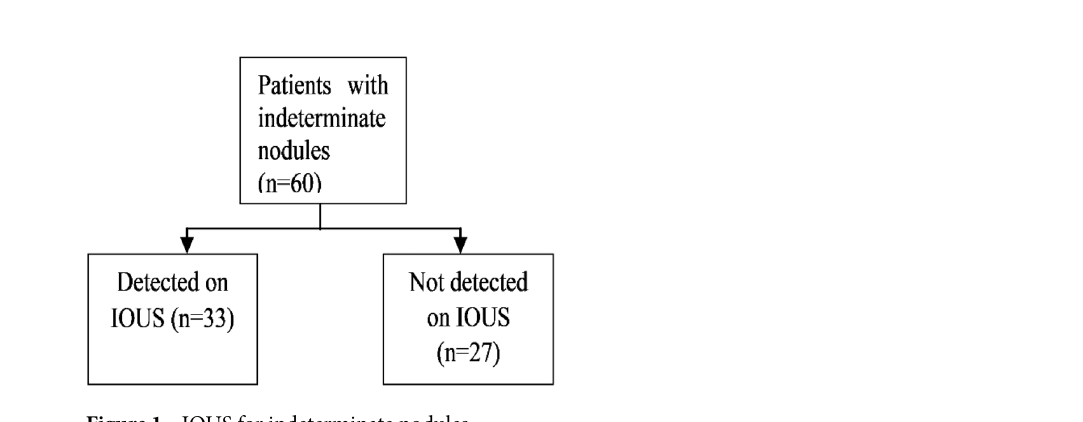
Figure 1. IOUS for indeterminate